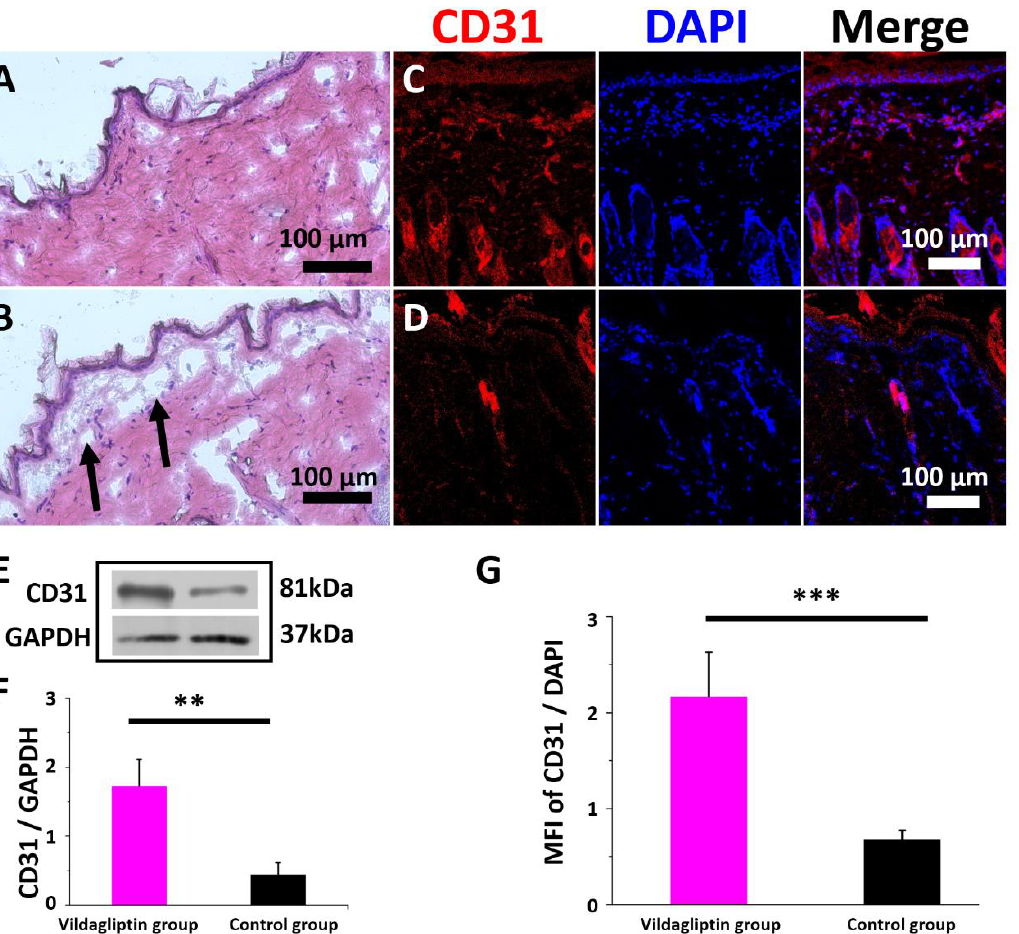
Figure 6. Histological images of the vildagliptin-eluting ( A ) and drug-free PLGA ( B ) group on day 14. Immunofluorescence of CD31 in the vildagliptin/PLGA ( C ) and drug-free PLGA ( D ) groups. Intensity ratio is obtained by densitometry as the ratio of the target protein to GAPDH density ( E ). Western blot and immunocytochemical quantification for CD31 relative to GAPDH or DAPI using the CD31/GAPDH ratio ( F ) or mean fluorescence intensity (MFI) of CD31/DAPI ( G ), respectively (scale bar = 100 μm) (** p < 0.01, *** p < 0.001).